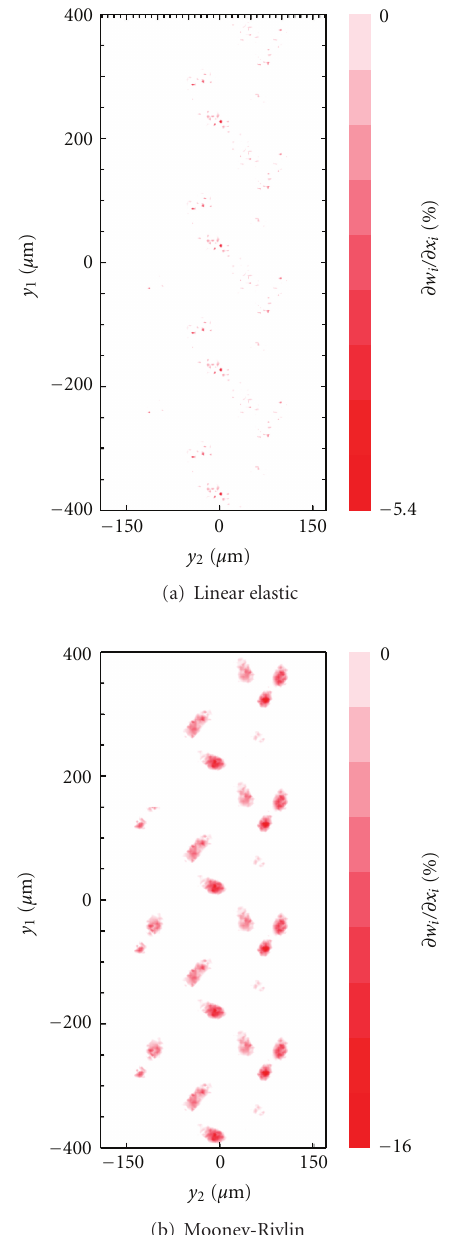
Figure 10: In-plane area